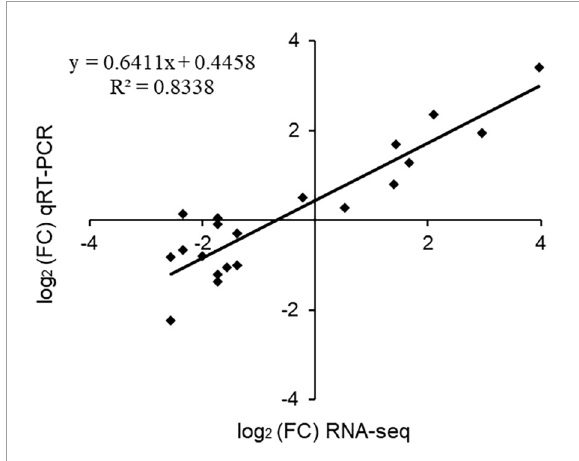
FIGURE9 Scatterplot of RNA-seq transcript abundance fold change values in RNA-Seq (on the x axis) against RT-PCR expression values (on y axis) for the 20 selected genes by RT-qPCR. The GADPH gene (XM_002263109) was used as the reference